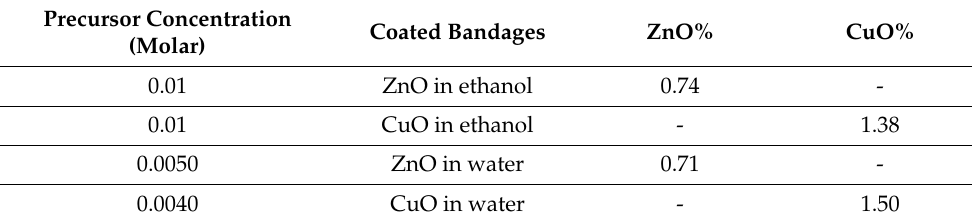
Table 1. Amounts of metal coated on the cotton